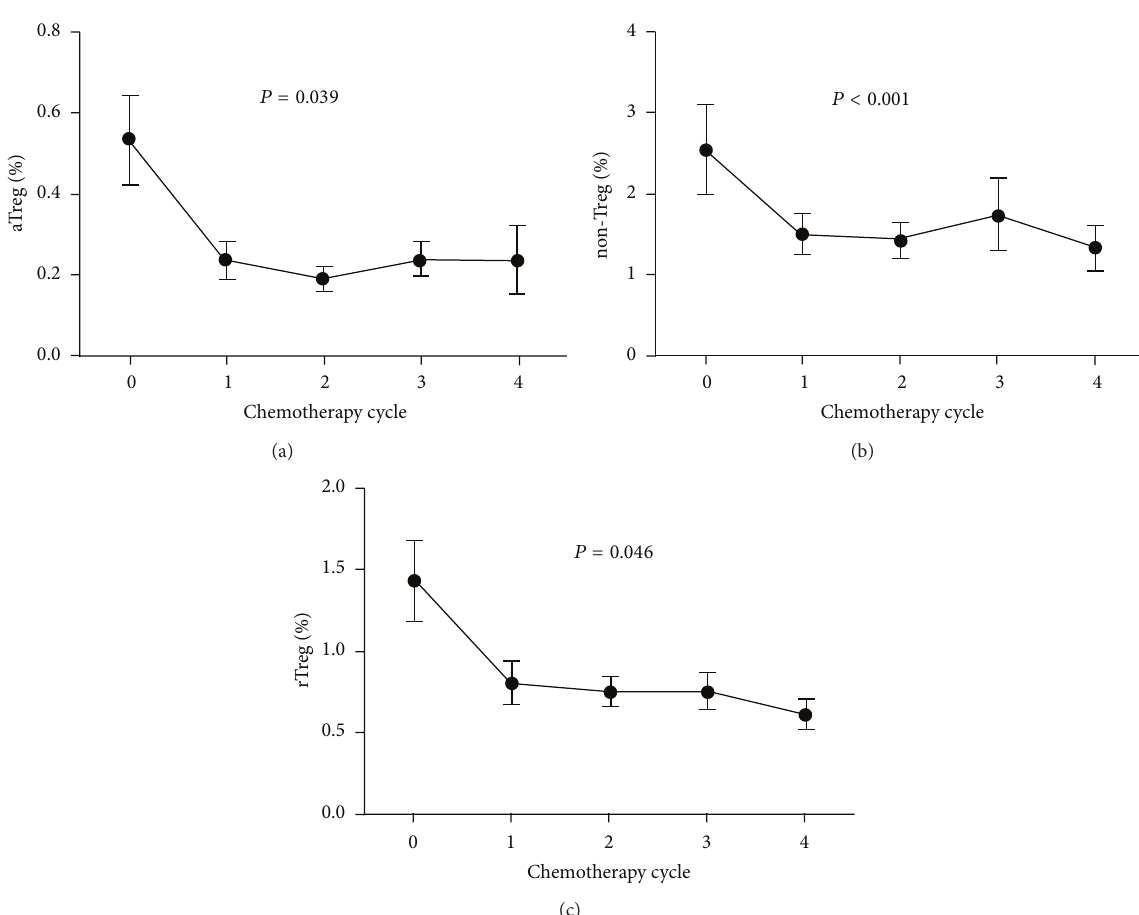
Figure5:TregcellsubsetsofNSCLCpatientsweredecreasedafterchemotherapy.ThepatientswithNSCLCreceived4cyclesofchemotherapy and the peripheral blood was collected 1 day before the first cycle and 2 weeks after each cycle. Three subsets were analyzed by FACS. Statistical analysis was determined by randomized block design ANOVA. ∗ 𝑃 < 0.05